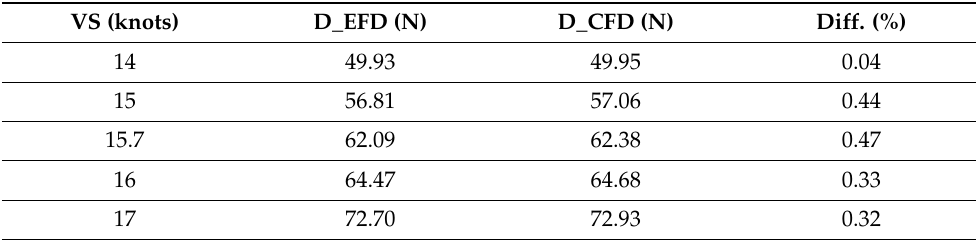
Table 3. Comparison of resistance of model-scale ship between EFD and CFD. Table 4. Comparison of self-propulsion analysis results between bare hull and with PSD.